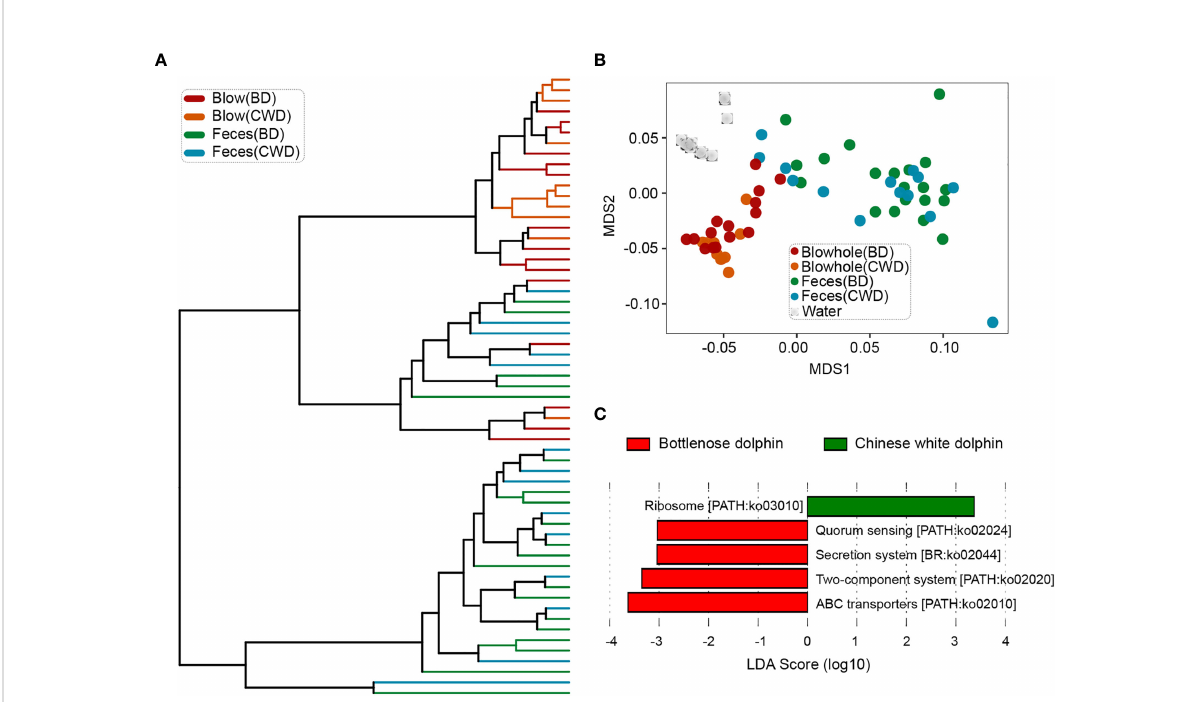
FIGURE 6 Convergence of the predicted functional composition of the dolphin microbiomes. (A) , the hierarchy clustering analysis of the dolphin microbial functional composition. (B) , the non-metric dimensional scaling (NMDS) analysis of microbial functional compositions based on the Bray-Curtis distances. (C) , pathways that were over-represented for both dolphin species identi fi ed by the Linear discriminant analysis Effect Size (LEfSe) analysis. BD indicates the bottlenose dolphin, and CWD indicates the Chinese white